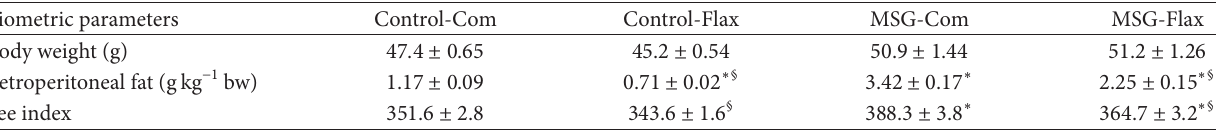
Table 2: Biometric parameters of mice at 90 days of age. Data are mean ± SEM of 18 mice from 3 different litters. The letters superscripts in each one of the values represent the significant differences among the groups by two-way ANOVA, where ∗ depicts statistical difference with 𝑃 < 0.01 compared to Control-Com group and § 𝑃 < 0.05 depicts statistical difference compared to MSG-Com